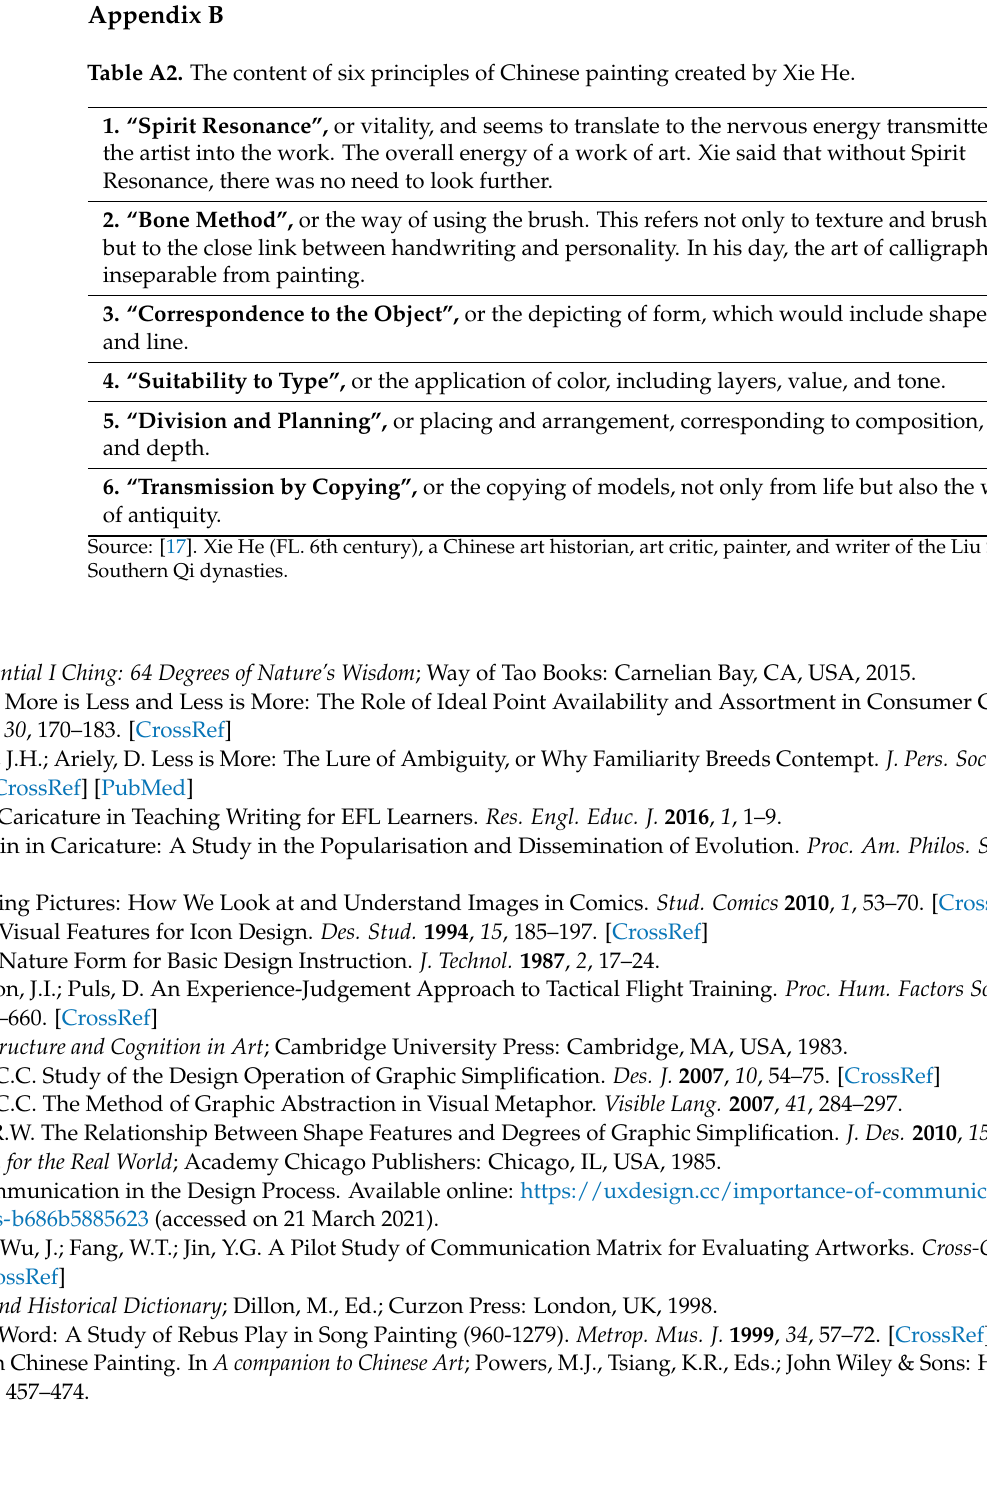
8. Which image highlights the cultural characteristics by forming visual images of symbols through form and spirit? (cid:3) A1 (cid:3) A2 (cid:3) A3 (cid:3) A4 (cid:3) B1 (cid:3) B2 (cid:3) B3 (cid:3) B4 (cid:3) C1 (cid:3) C2 (cid:3) C3 (cid:3) C4 (cid:3) D1 (cid:3) D2 (cid:3) D3 (cid:3) D4 9. Which image reflects the conception and neglects the form and becomes an objective symbolic image? (cid:3) A1 (cid:3) A2 (cid:3) A3 (cid:3) A4 (cid:3) B1 (cid:3) B2 (cid:3) B3 (cid:3) B4 (cid:3)